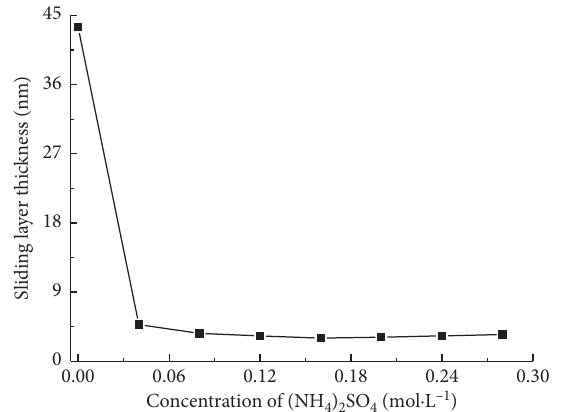
Figure 3: Variation of sliding layer thickness on ore particle